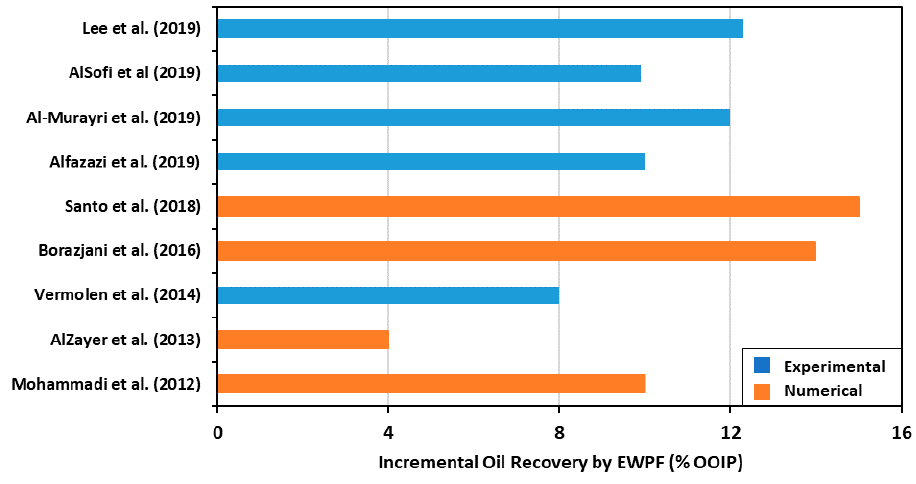
Figure 4. Summary of experimental and simulation studies involving incremental oil recovery using engineered water–polymer flooding (EWPF) in carbonates.4.1. Enhanced Oil Recovery using Hybrid EWPF in Carbonates.